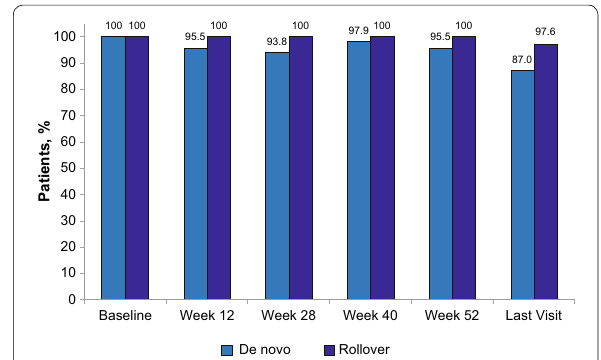
Fig. 3 Percentage of patients remaining stable throughout the AOM 400 maintenance phase, by enrollment source. Stability defined as (1) outpatient status, (2) Young Mania Rating Scale total score 12, ≤ (3) MADRS total score 12, and (4) no active suicidality, with active ≤ suicidality defined as MADRS item 10 score 4, or “yes” on question 4 ≥ or 5 of the Columbia Suicide Severity Rating Scale. MADRS Montgom-